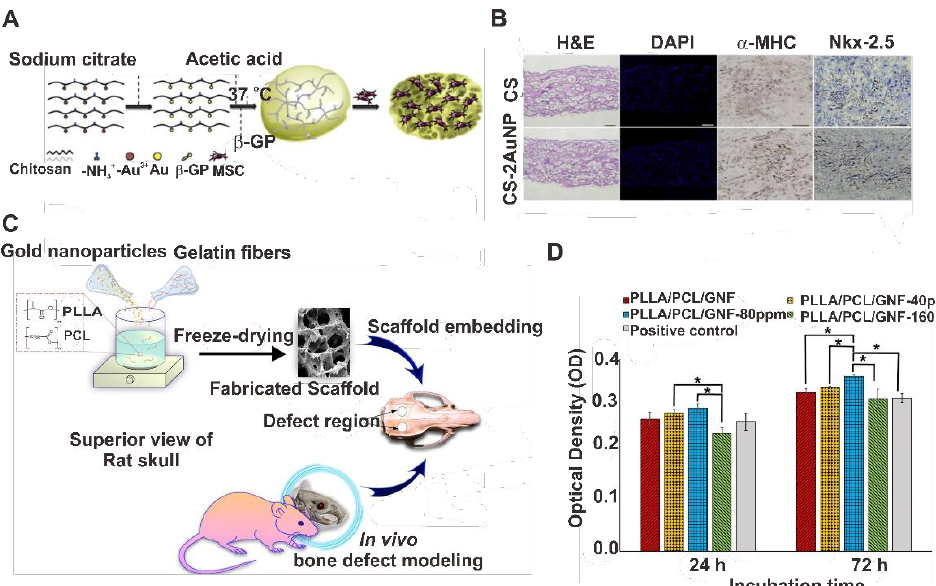
Figure 10. ( A ) Schematic illustration of the preparation and in vitro seeding of the CS-AuNP scaf- fold. ( B ) Morphology, distribution, and differentiation of MSCs within the CS-AuNP scaffolds. Hematoxylin and eosin and DAPI staining (scale bar: 200 μm) and immunohistochemistry analyses of Nkx-2.5 and α-MHC (scale bar: 50 μm) in a CS or CS-2AuNP hydrogel after 14 days of culture. ( C ) Schematic representation of the working principle of gelatin fiber scaffolds with AuNPs. ( D ) MG-63 cell proliferation on the synthesized gelatin fiber scaffolds with 24 h, 72 h incubation time, * p < 0.05. Reproduced with permission from [165] , Elsevier, 2016; and [170] , Nature Portfolio, 2021.